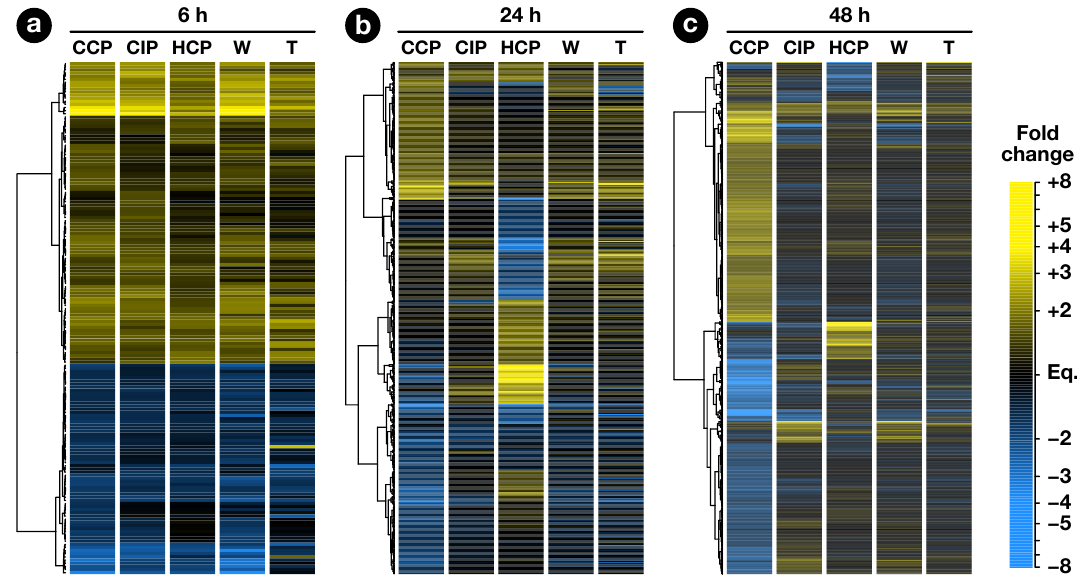
Figure 2. Hierarchical clustering analysis of regulated genes. Each row represents a gene and each column represents a condition. At each time point, the analysis was performed using genes regulated in at least one pollination condition. Euclidean distances between expression ratios in CCP, CIP and HCP vs. unpollinated ovule (UO) were used in a hierarchial clustering analysis based on Ward’s method. Expression ratios in stigma wounding (W) and touch (T) conditions vs. UO were then added to the